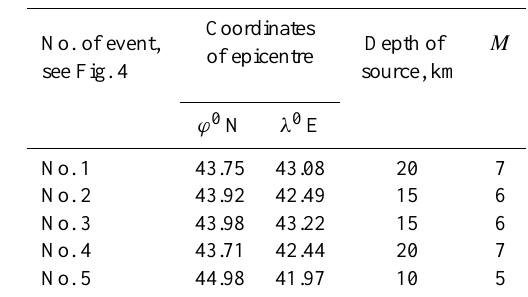
Table 4. Parameters of scenario earthquakes for the most hazardous source